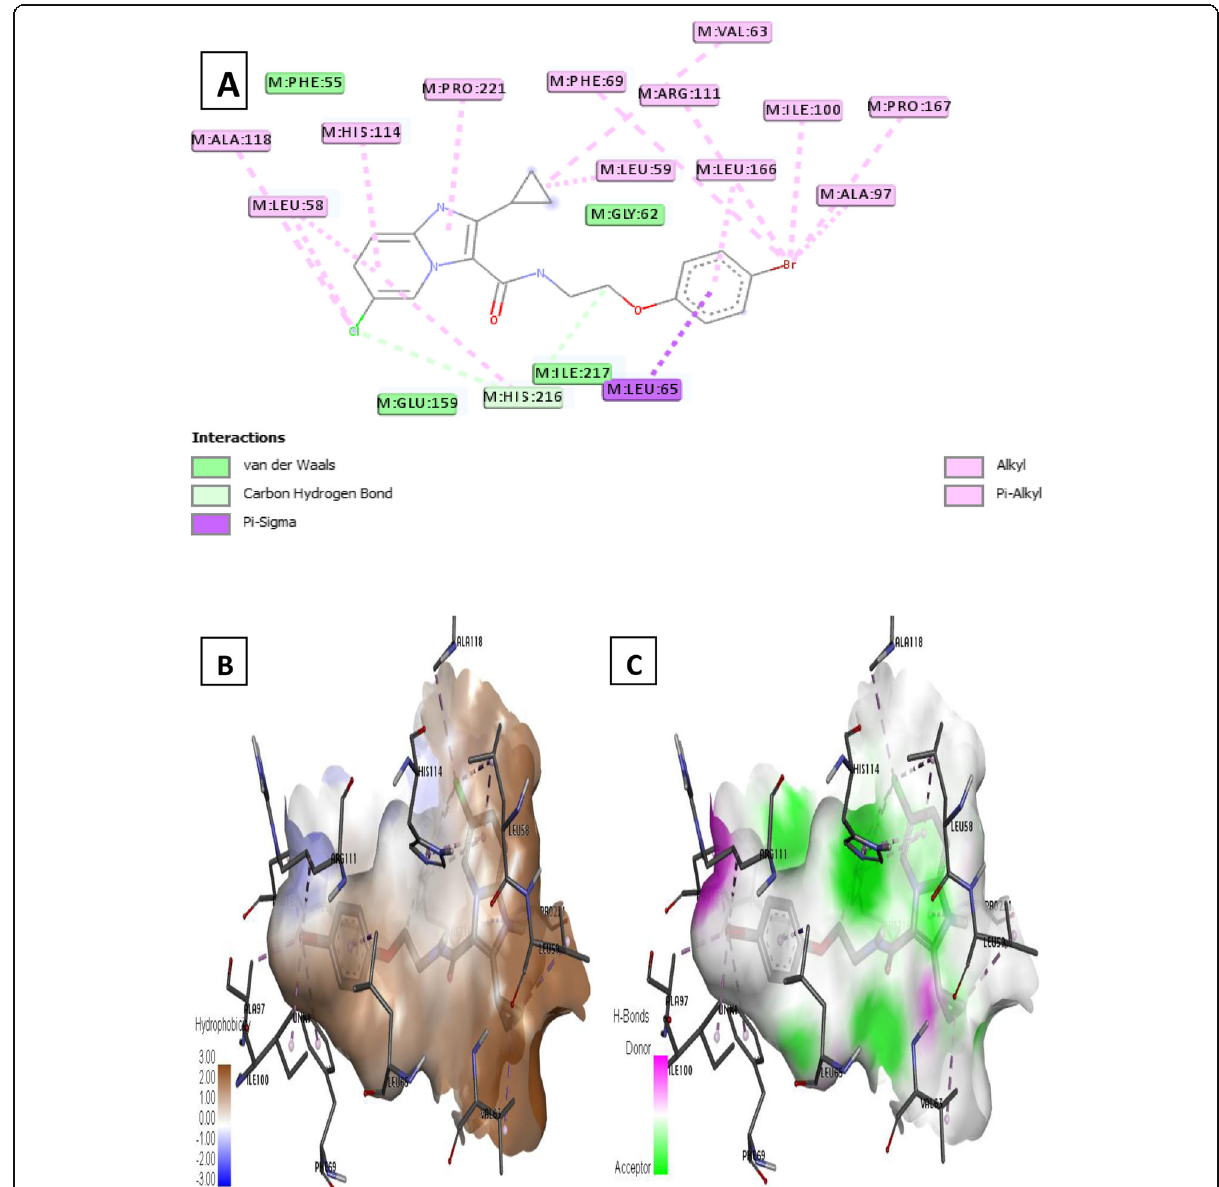
Fig. 8 Docking interaction of complex 22. a 2D docked view of complex 22. b Hydrophobicity surfaces of complex 22. c Hydrogen bond surfaces of complex